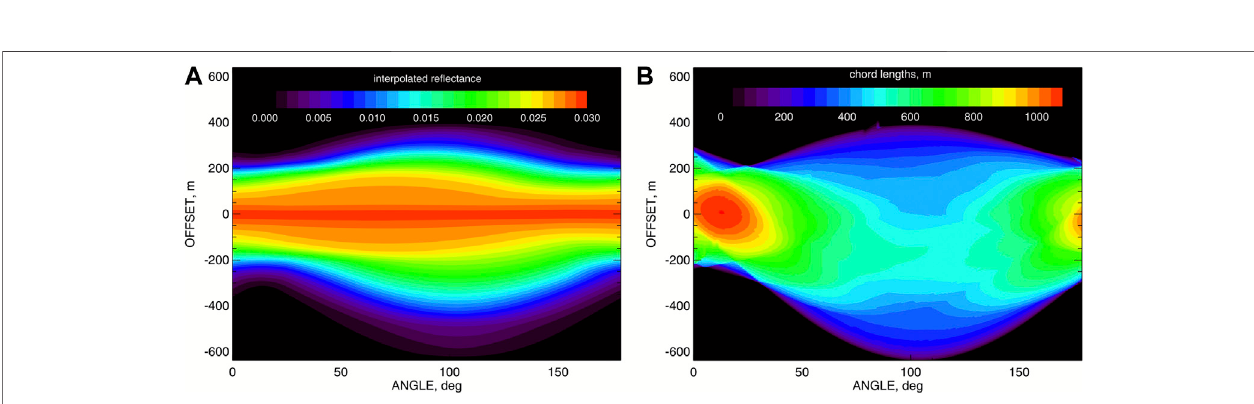
FIGURE 7 | (A) The re fl ectance tomogram R tom ( ψ , ρ ) computed for the RPD from Figure 6B by taking its maxima along the chords. (B) chord-length tomogram L tom ( ψ , ρ ) consisting of the lengths of the same chords when bounded by the cloud shape corresponding to the lowest brightness threshold (0.0015).